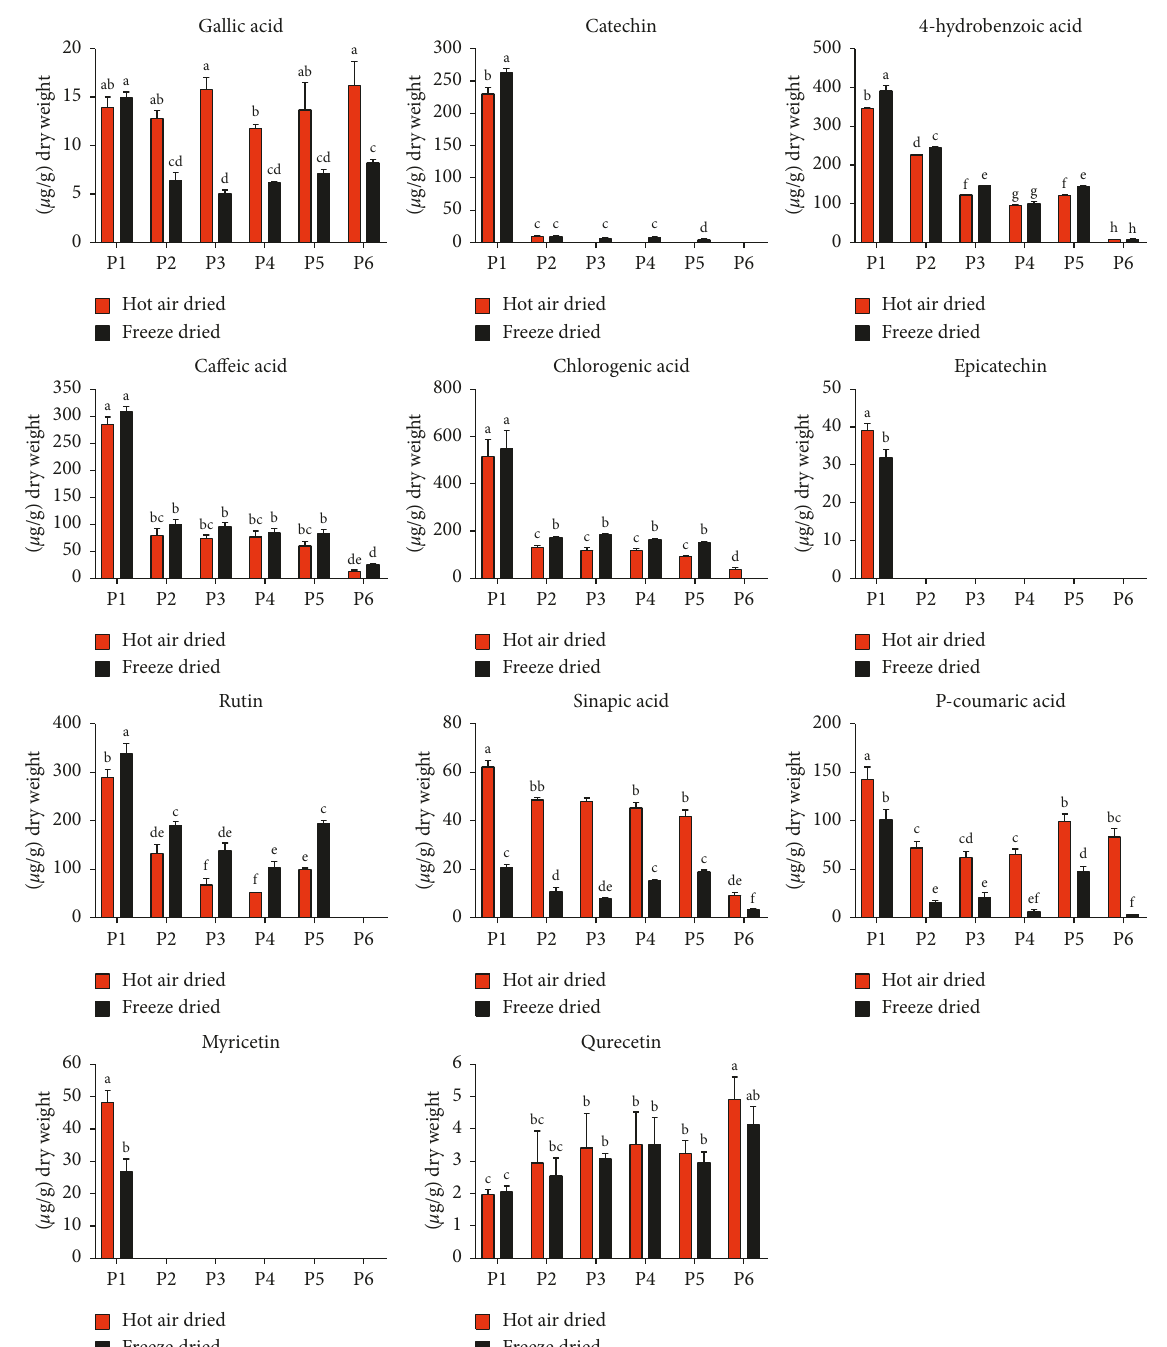
Figure 2: Accumulation of phenolic compounds in different parts of cabbage ( μ g/g DW). Mean and standard deviation were obtained from three independent experiments. Letters a–h indicate significant differences ( P < 0 . 05). P1, leaves part 1; P2, leaves part 2; P3, leaves part 3; P4, leaves part 4; P5, leaves part 5, P6, leaves part